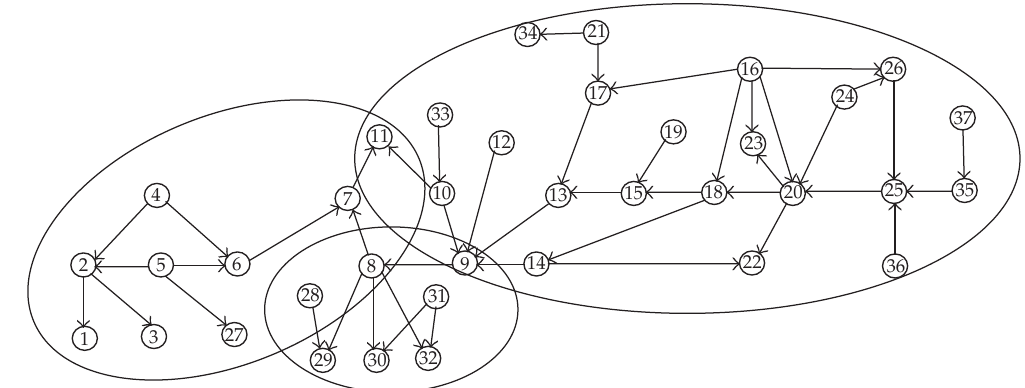
Figure 3: The ALARM network and multiple